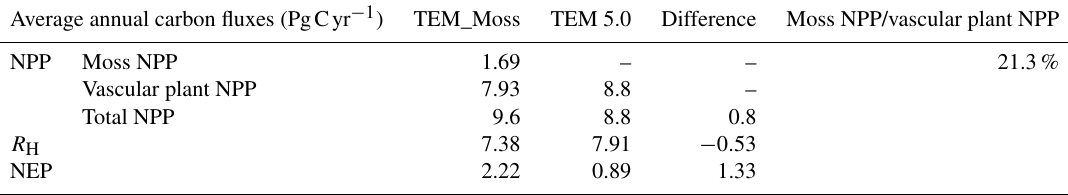
Table 9. Average annual NPP, R H , and NEP (as Pg C per year) during the 20th century estimated by two models. Average annual carbon fluxes (PgCyr − 1 ) TEM_Moss